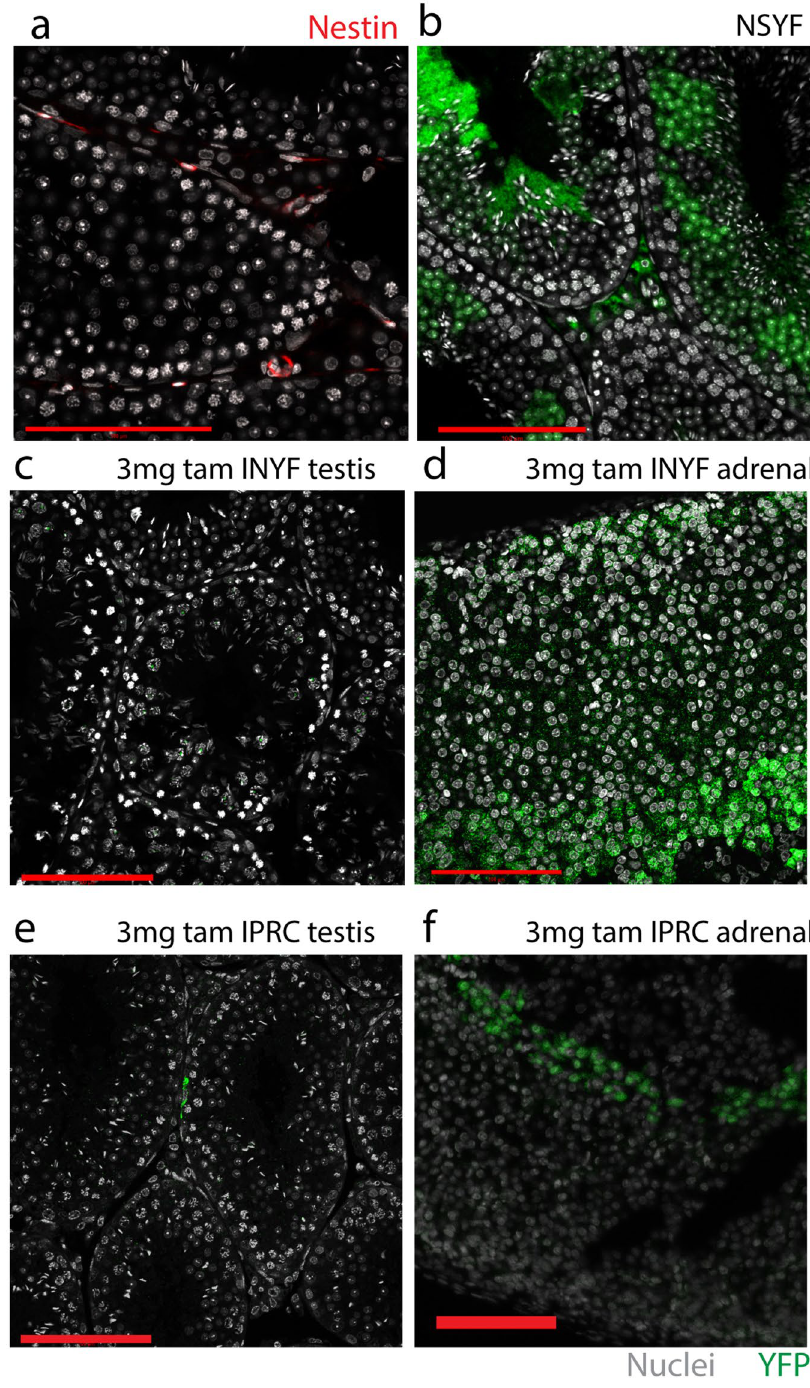
Figure 1. A single dose of 3 mg tamoxifen induces adrenal but not testis transgene expression. ( a ) A population of interstitial cells immunostain for nestin (red) in control testis sections at d35. ( b ) A population of interstitial cells immunostain for YFP (green) in testis sections from NSYF mice injected at d21 and examined at d35. ( c ) No YFP staining is seen in testis sections from d35 INYF mice treated with a single 3 mg dose of tamoxifen at d21. ( d ) YFP staining is seen in adrenal sections from a d35 INYF mouse treated with a single 3 mg dose of tamoxifen at d21 (green). ( e ) Localisation of Confetti fluorescent protein is restricted to small focal areas in d35 IPRC testes treated with a single 3 mg dose of tamoxifen at d21(green). ( f ) Confetti protein is seen in adrenal sections from d35 IPRC mice treated with a single 3 mg dose of tamoxifen at d21 (green). Scale bars are all 100 µ